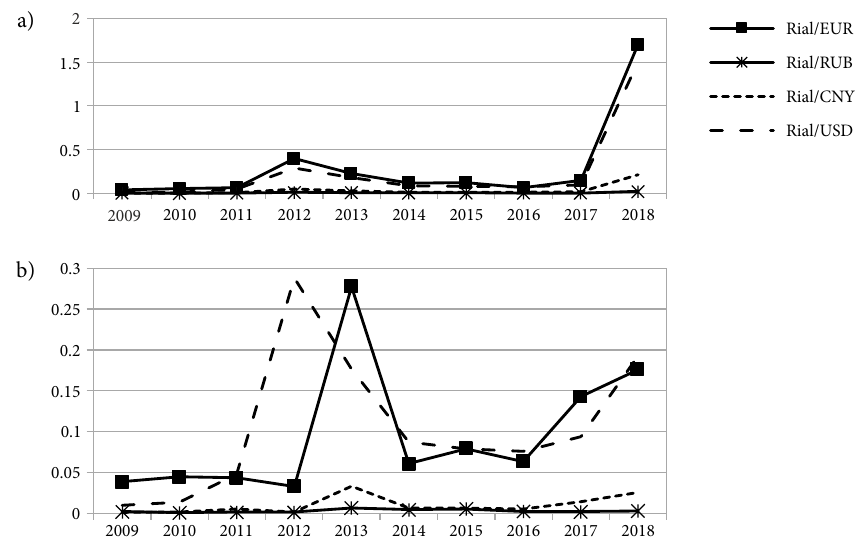
Note: Volatility means average of the standard deviations of the change in the logarithm of the exchange Figure 1. Exchange rate volatility based on monthly data: a – unofficial, b – versus official rates (source: own elaboration based on CBI, 2020 and Sauder, 2020)